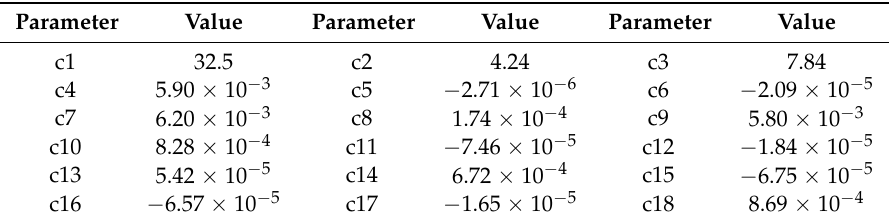
Table 1. Compensation parameters of OPM-I.